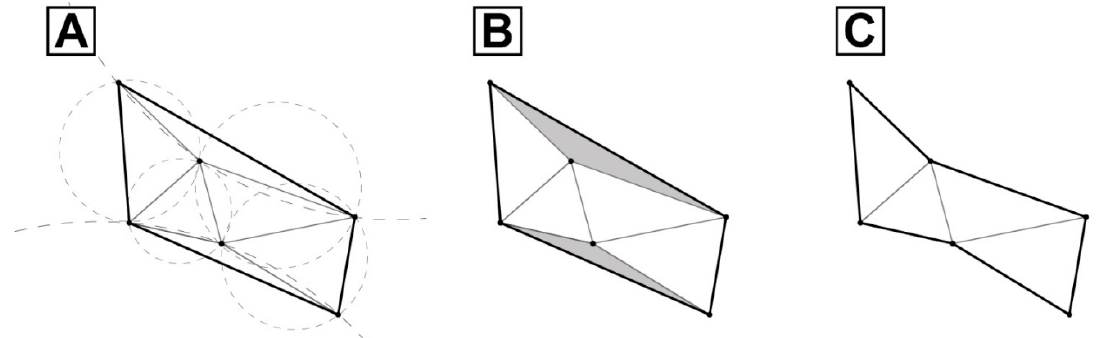
Figure 3 . Example of 2D projection of the α -shape hull construction concept. ( A ) Outer surface Delaunay triangulation (DT, convex shape) with all simplex triangles and circumscribing circles. ( B ) Gray triangles are defined by circumscribing circles with a radius larger than the defined research radius α . ( C ) New outer surface from the α shape with concavities formed by the points. The shape is an α -complex compound of multiple simplexes (triangles) from DT.